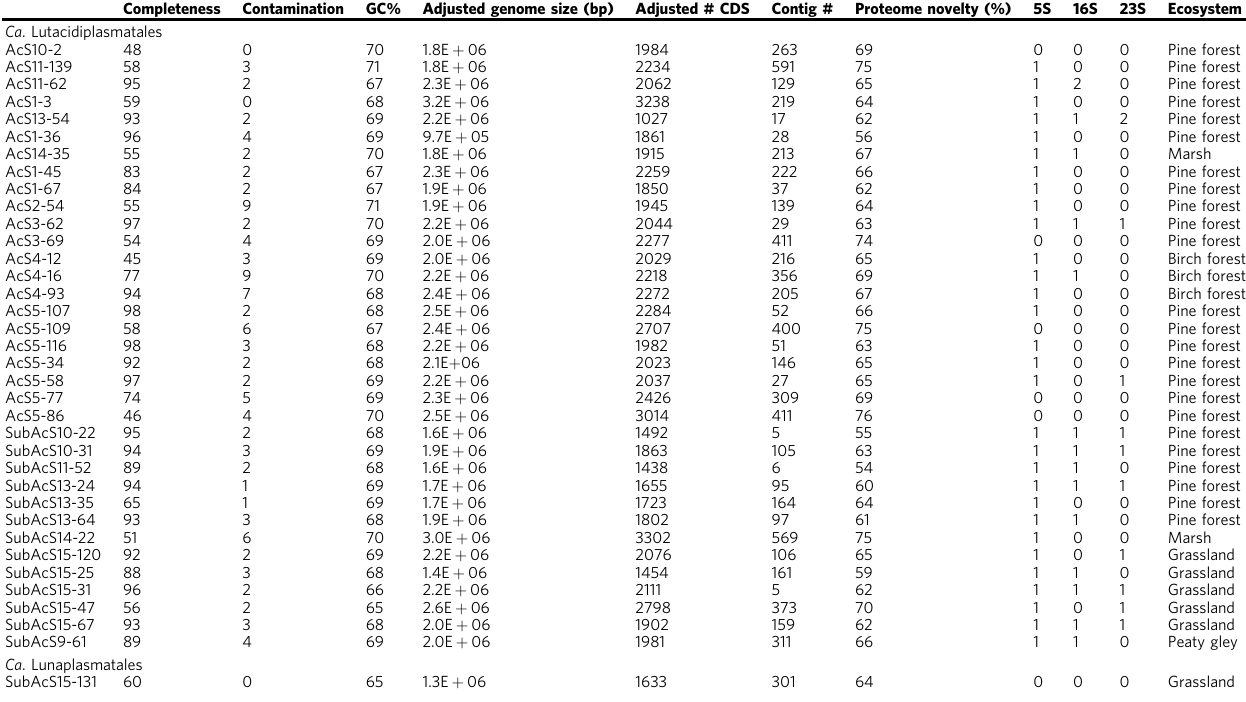
Table 1 Genome characteristics of newly sequenced metagenome-assembled